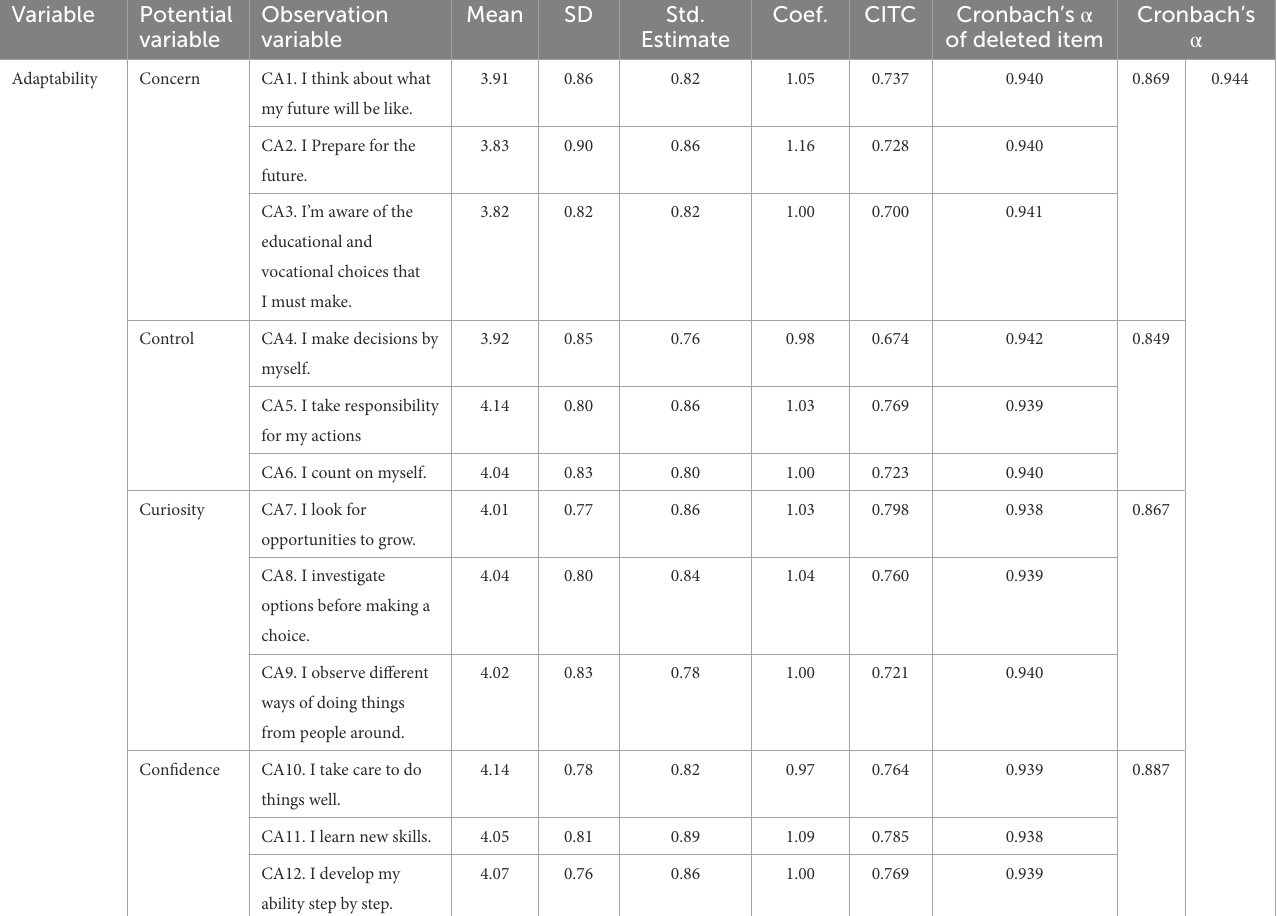
TABLE 1 Reliability Analysis Results of CAAS-SF China and the Relevant Data of the Observation Variable.